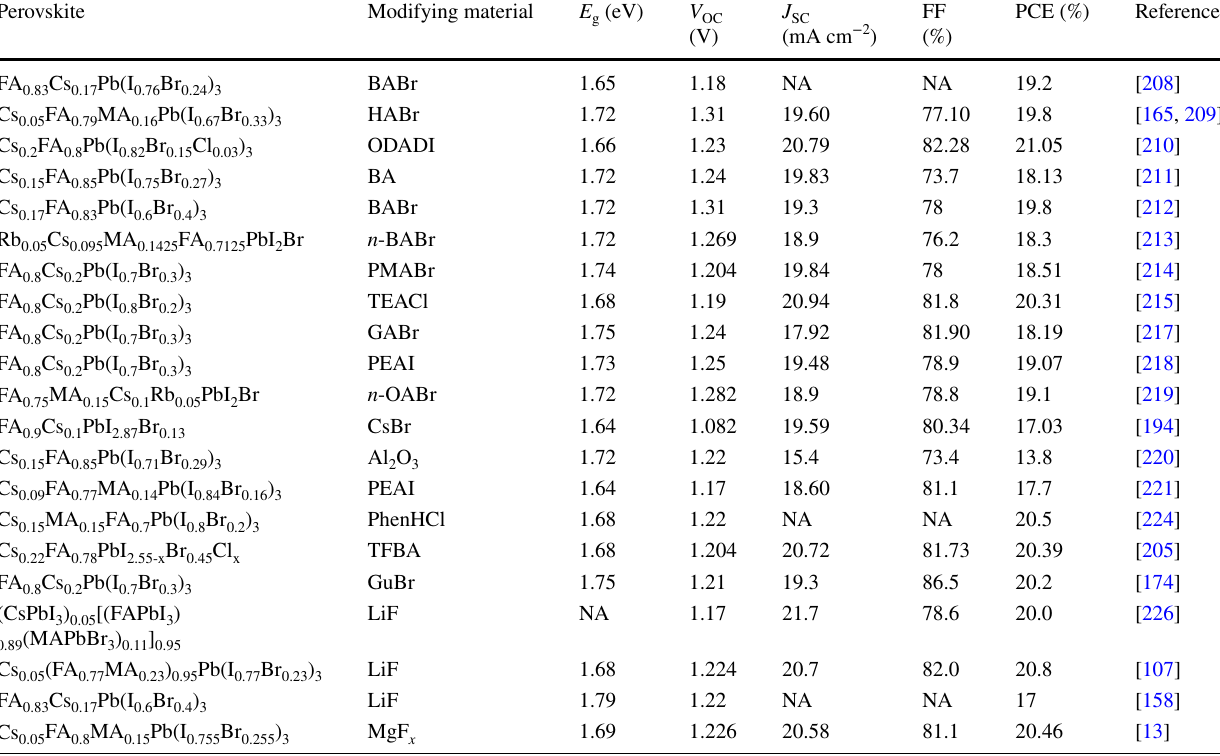
Table 5 Summary of WBG PSCs employing interface engineering Perovskite Modifying